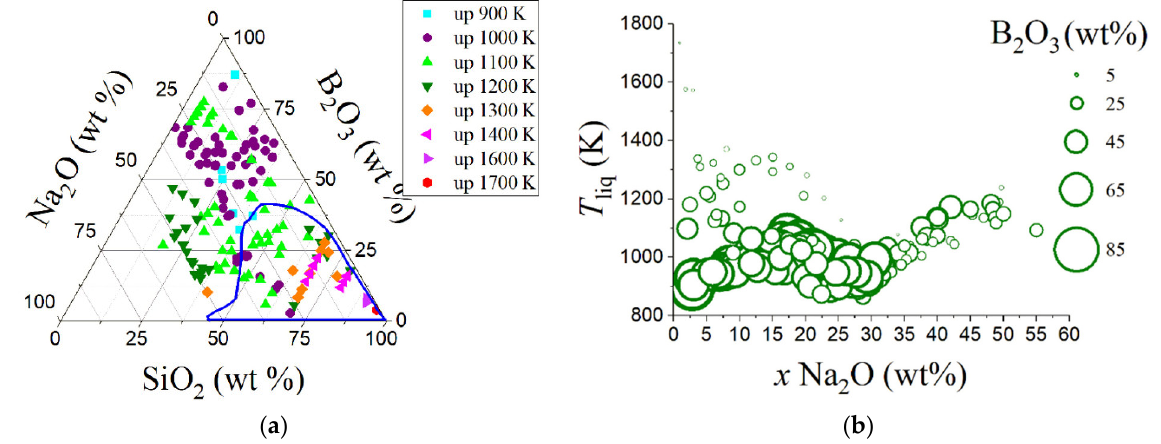
Figure 5. ( a ) Ternary diagram of selected sodium borosilicate glasses from Sciglass TM database (version 7.9). The blue region corresponds to approximately the T liq behavior from a plethora of sodium borosilicate waste-immobilization glasses. ( b ) The liquidus temperature ( T liq , in K) dependence on sodium oxide content. In this graph, it is possible to observe that the liquidus temperature decreases when sodium oxide increases up to near 30%, and boron oxide has also an important role.